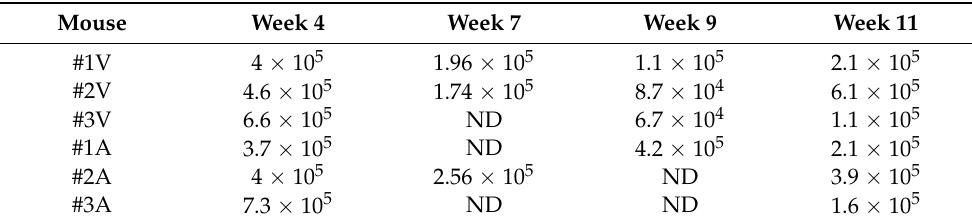
Table 3. Viral DNA copy numbers in vaginal (V) and anal (A) tracts of three mice infected with L2ATGko mutant MmuPV1 over